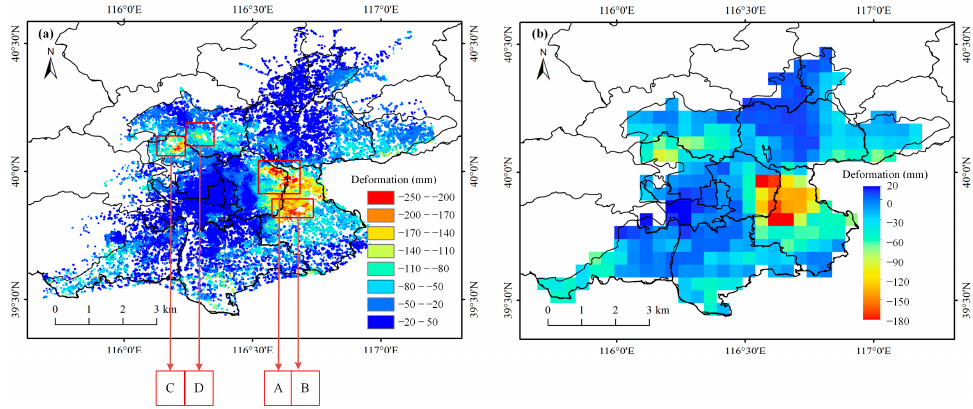
Figure 6. Deformation retrieved by InSAR in the Beijing Plain from May 2017 to July 2020. ( a ) Vector image with persistent scatterers. The cones of depression are located at A, B, C, and D, respectively; ( b ) Raster image at the resolution of 0.05°.